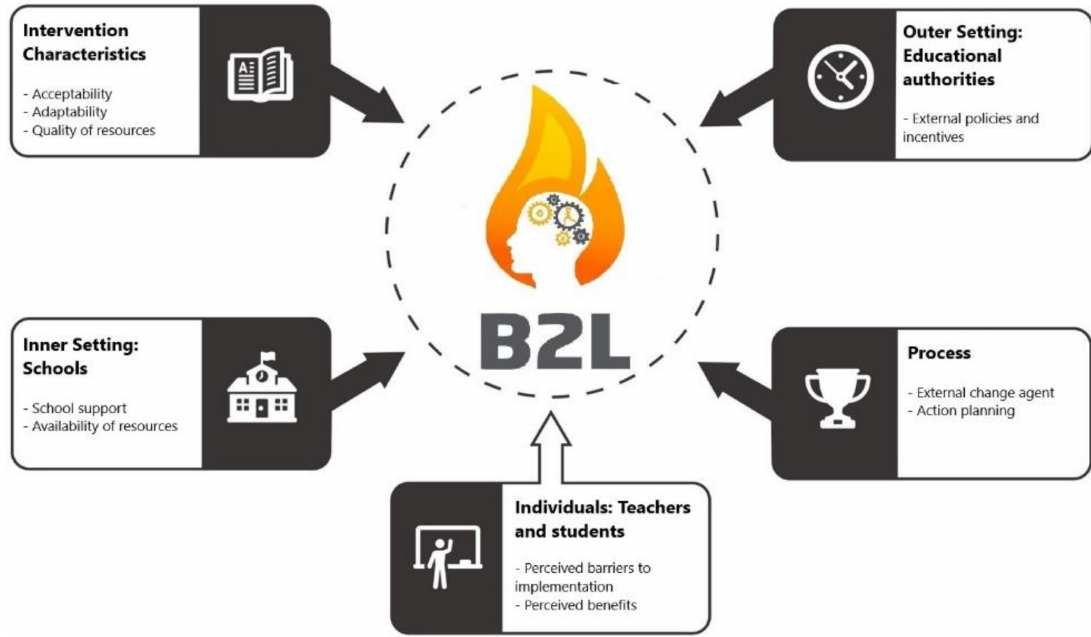
Figure 2. Operationalisation of Consolidated Framework for Implementation Research (CFIR) domains for the B2L